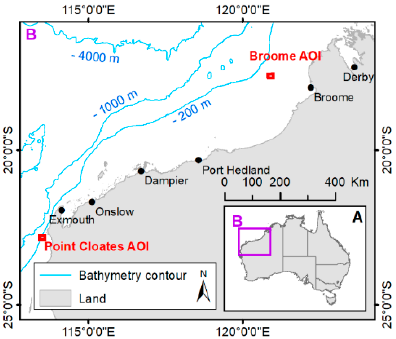
Figure 1. Location of areas of interest used to trial the workflow.